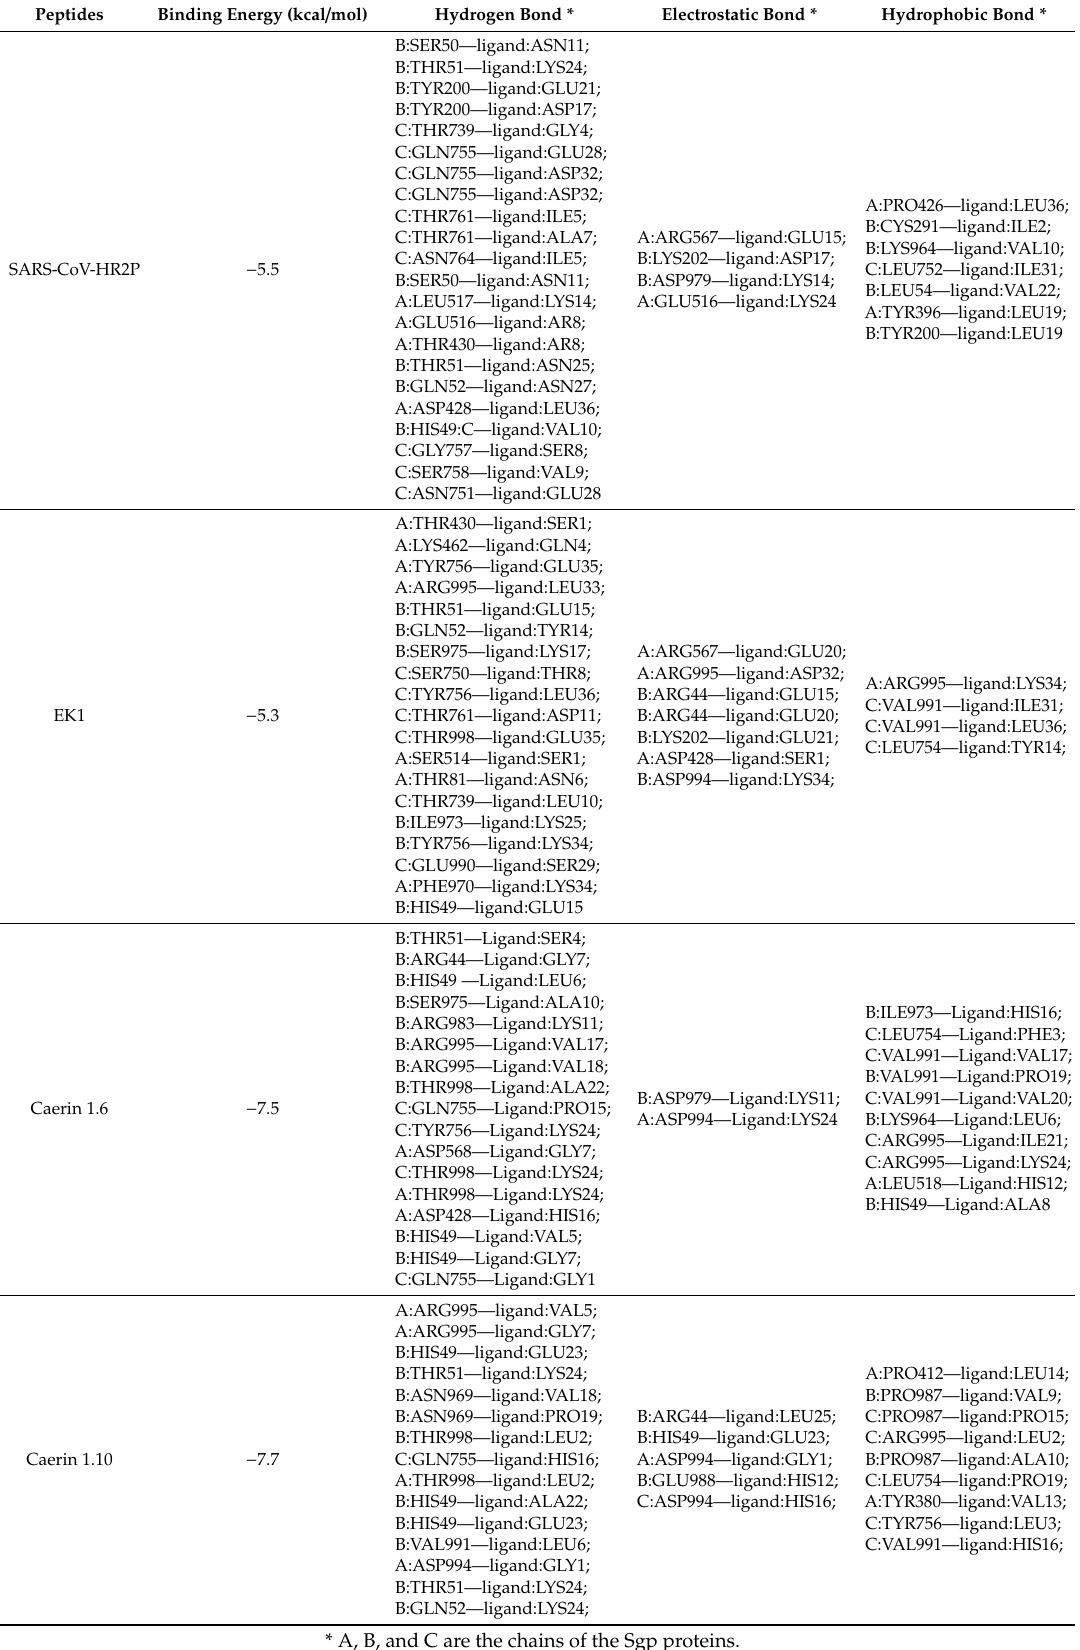
Table 5. Comparison of binding energy and interactions between control peptides and caerins to the